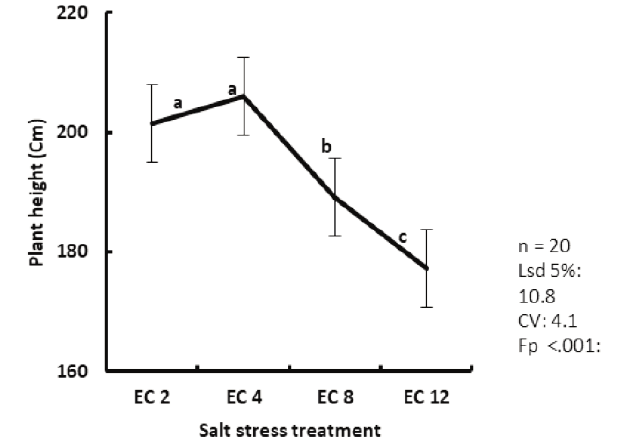
Fig. 4 ­ Effect of different concentration of “onsen” water on height of tomato plants variety ‘Reika’ in the greenhou­